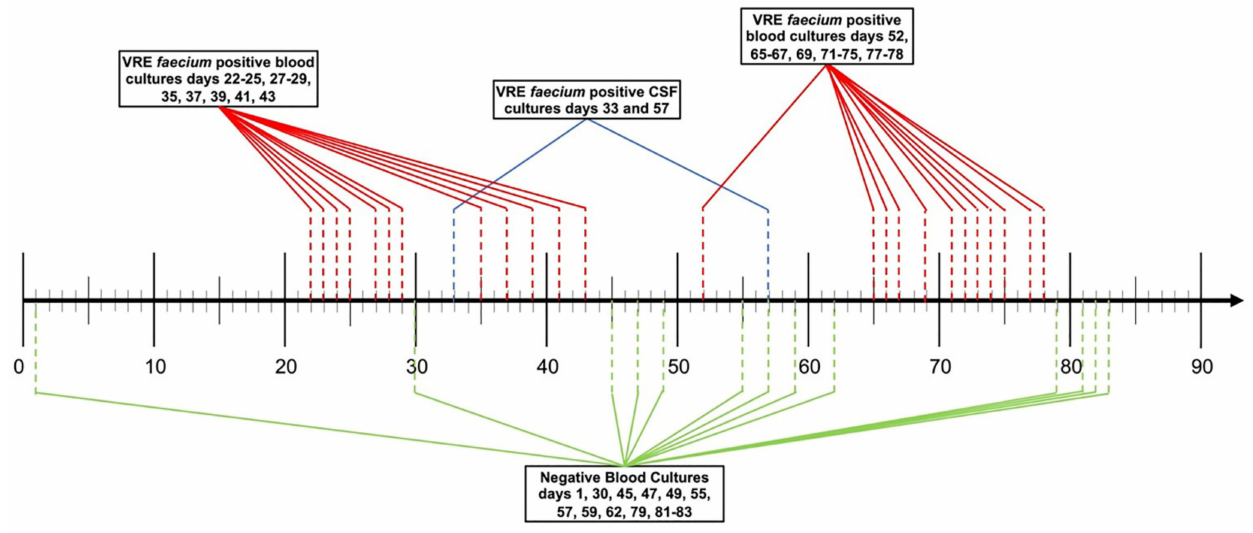
Figure 1. Timeline of VRE culture results from blood and CSF throughout the hospital admission.